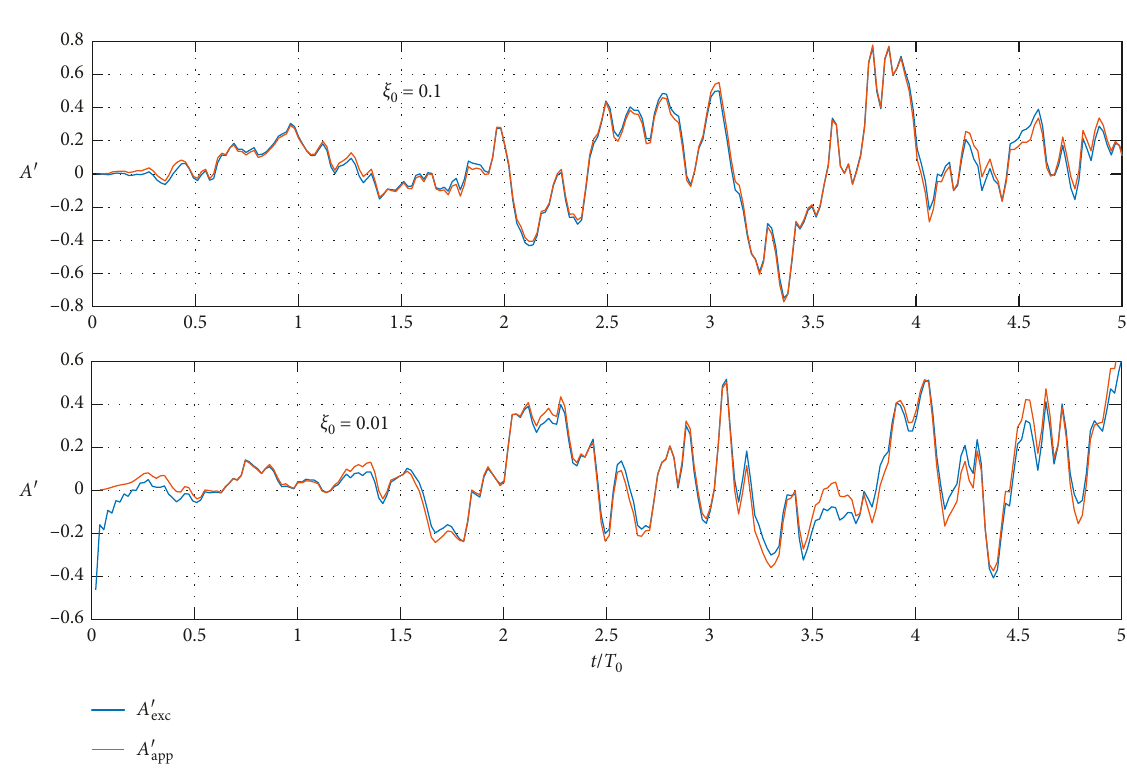
max (cid:31) 10 T 0